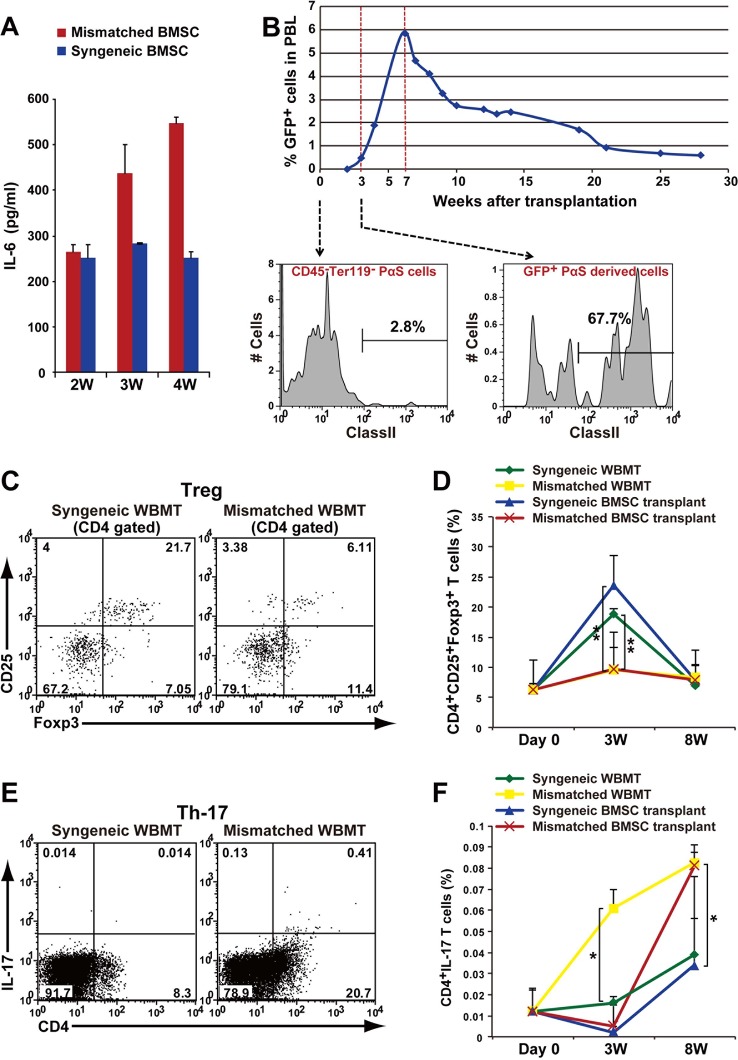
Autoimmune phenotype following mismatched BMSC transplantation.(A) Serum IL-6 concentration increased after mismatched BMSC transplantation (red) compared to syngeneic control (blue). Duplicate experiments. Data are shown as mean ± SD, n = 2. (B) GFP+ donor BMSCs appear in peripheral blood mononuclear cells after mismatched BMSCs transplantation, and peaks at approximately 7 weeks. The percentage of BMSCs expressing MHC class II antigen increases following transplantation. (C) CD4+ CD25+ Foxp3+ Tregs were suppressed in the spleen after mismatched WBMT transplantation (right) compared to syngeneic control (left). (D) CD4+CD25+Foxp3+ Tregs were suppressed in both mismatched WBMT (yellow) and mismatched BMSC transplantation (red) compared to syngeneic WBMT (green) or syngeneic BMSCs transplantation (blue). Data are shown as mean ± SD, triplicate experiments, n = 3–5, **p<0.01. (E, F) The ratio of CD4+ IL-17+ T cells in the spleen was significantly higher following mismatched WBMT (yellow) or mismatched BMSC transplantation (red) compared to syngeneic control (green and blue). Data are shown as mean ± SD, triplicate experiments, n = 3–5, *p<0.05. BMSCs, bone marrow stromal/stem cells; SD, standard deviation.DOI:
http://dx.doi.org/10.7554/eLife.09394.02910.7554/eLife.09394.030Figure 7—source data 1.Serum IL-6 concentration after mismatched BMSC transplantation compared to syngeneic BMSC transplantation.Data are from 2, 3, and 4 weeks after mismatched and syngeneic BMSC transplantation shown in (A).DOI:
http://dx.doi.org/10.7554/eLife.09394.03010.7554/eLife.09394.031Figure 7—source data 2.Serial changes of CD4+CD25+Foxp3+ Tregs in spleen cells.Raw data and average values for statistical analysis use in (D) are shown.DOI:
http://dx.doi.org/10.7554/eLife.09394.03110.7554/eLife.09394.032Figure 7—source data 3.The ratio of CD4+ IL-17+ T cells in the spleen cells.Raw data and average values for statistical analysis used in (E) are shown.